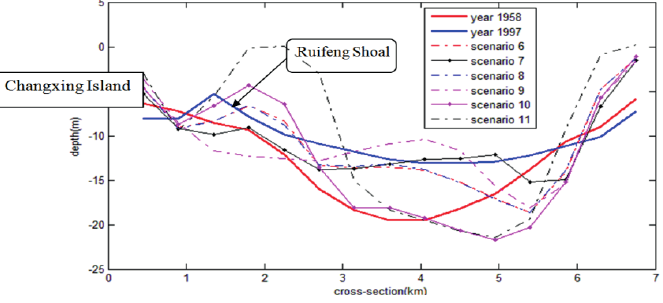
Fig.4 Cross-section of the South Channel for scenarios